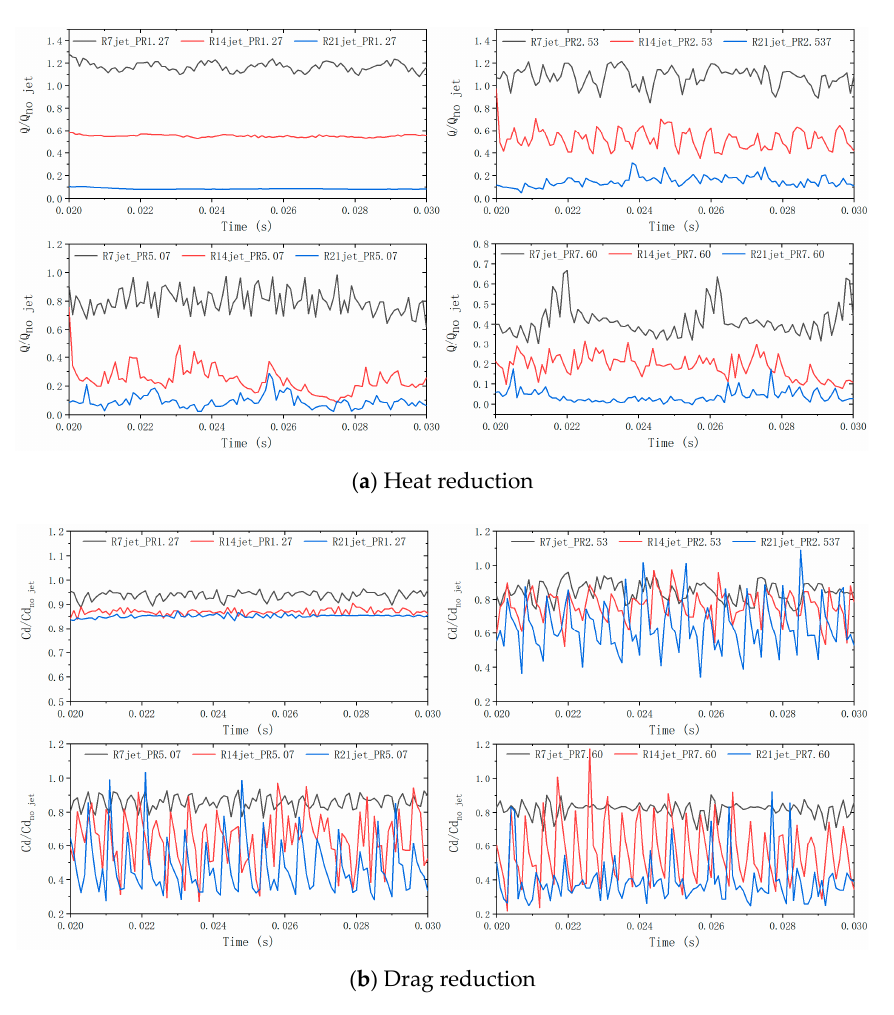
Figure 14. Heat reductions of R7, R14, and R21 jets with the PRs 1.27–7.60.